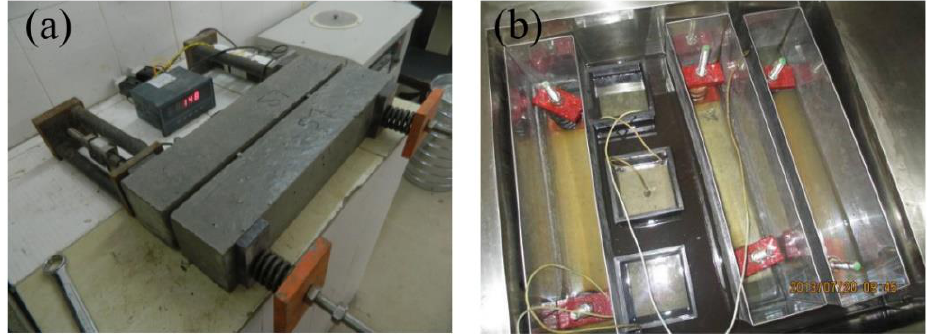
Figure 1. The concrete specimens under ( a ) flexural load and ( b ) freeze – thaw.